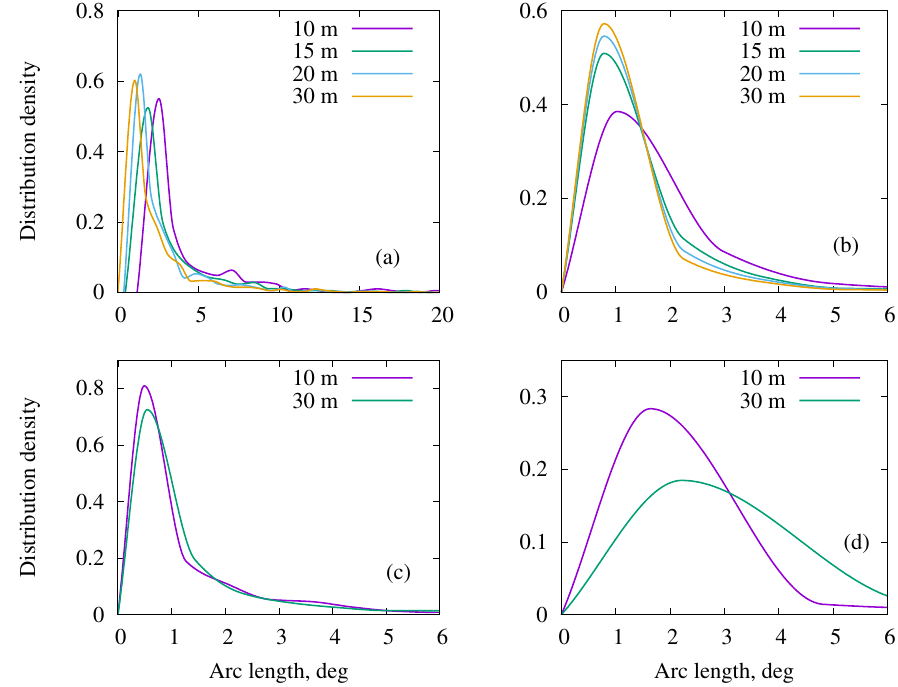
Figure 8. Distribution of arc length in the shade of trees at different distances: ( a ) simulation, pine stand; ( b ) Leica TLS measurements, 2013, pine stand; ( c ) Trimble TLS measurements, 2019, spruce stand; and ( d ) TLS measurements, 2013, birch